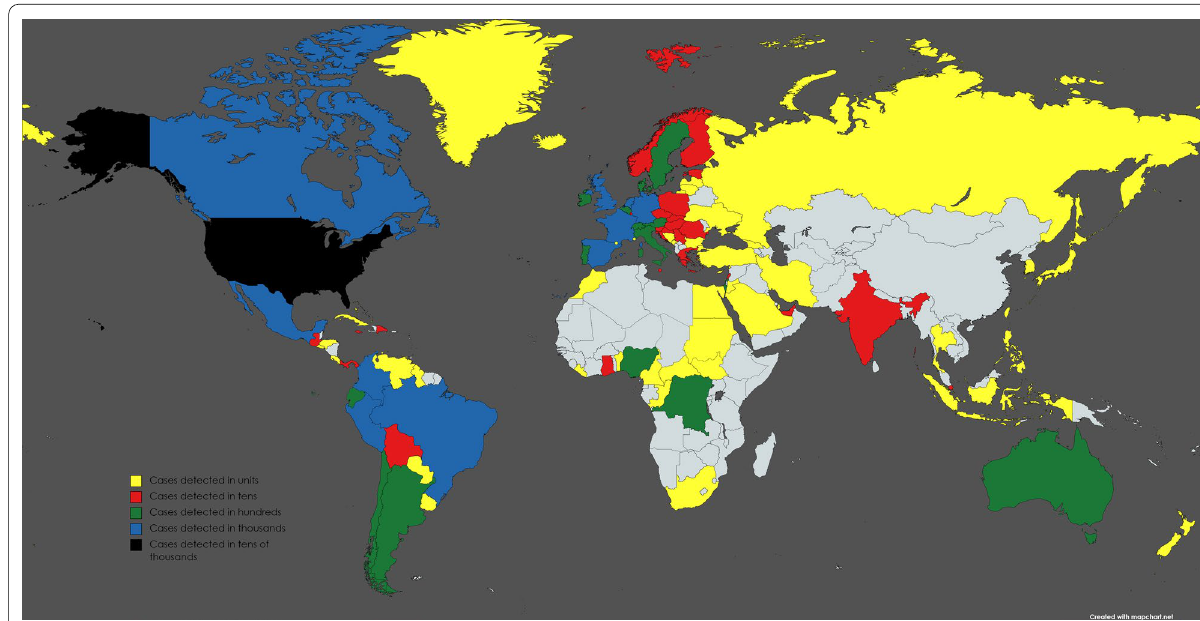
Fig. 1 World map showing countries with monkeypox cases based on numbers that is obtained from centers of disease control and prevention by 28th of September 2022. countries in yellow represent that numbers of cases detected in single digit (units), red represent detected cases in tens, green represent detected cases in hundreds, blue represent detected cases in thousands, and black represent detected cases in tens of